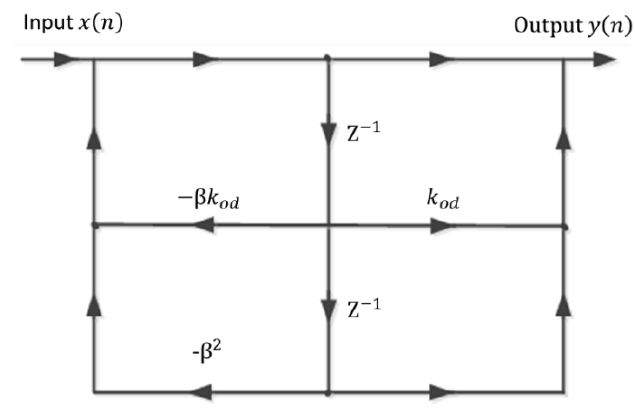
Figure 6. Second IIR NF realized in direct form.